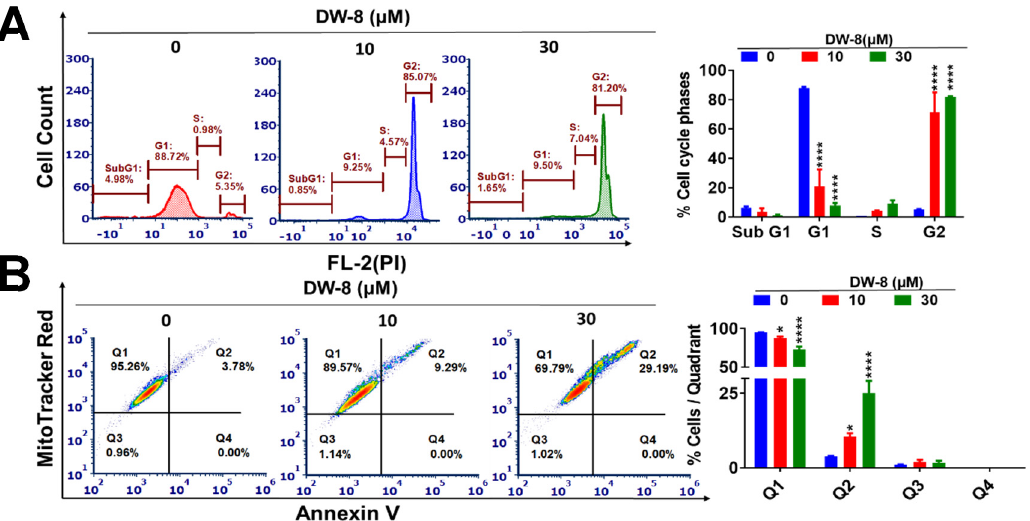
Figure 2. The effect of DW-8 on the apoptosis and cell cycle phases of SW620 cells. ( A ) A representative figure showing the effect of DW-8 on the phases of the cell cycle in SW620 cells. A histogram quantitatively summarizing the change in the percentage of cells in each phase of the cell cycle after incubation with DW-8 . ( B ) A representative figure showing the induction of apoptosis by vehicle, 10 or 30 µ M of DW-8 , based on data obtained using the MitoTracker Red and Alexa Fluor 488 Annexin kits. A histogram summarizing the same results is also shown; * p < 0.05, **** p < 0.0001. The data represent means ±SD of three independent experiments performed in triplicate. FL-2 indicates the gate used in a flow cytometer. PI is the abbreviation for Propidium iodide.